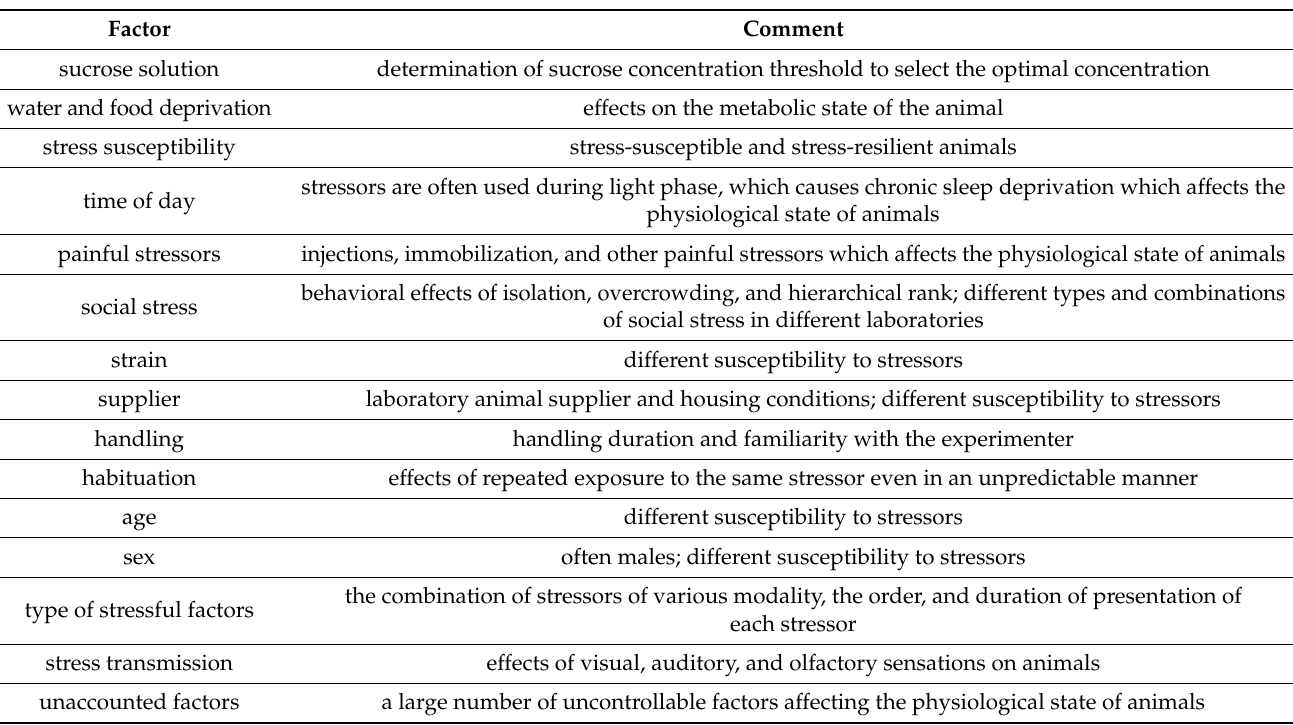
Table 1. Possible sources of poor